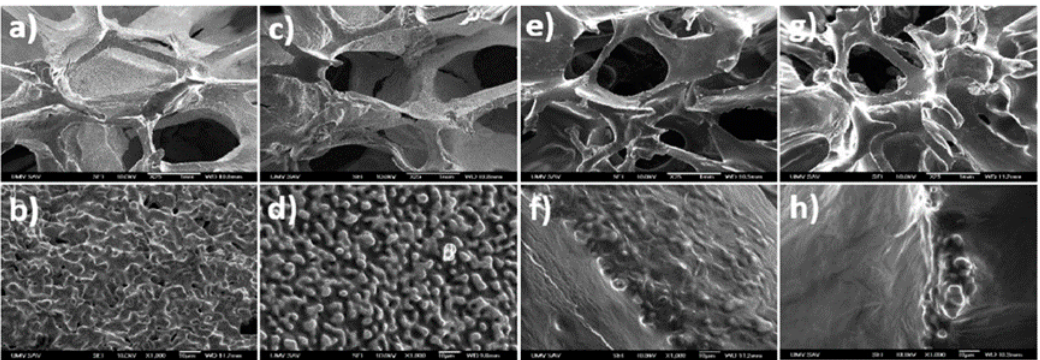
Figure 11. SEM micrographs of the surface of iron-based foams: Fe sample ( a , b ), Fe-PEG1 ( c , d ), Fe-PEG2 ( e , f ); and Fe-PEG3 ( g , h ). Magnification: 25 × ( a , c , e , g ); 1000 × ( b , d , f , h ). Reprinted from [49] with permission from Elsevier.